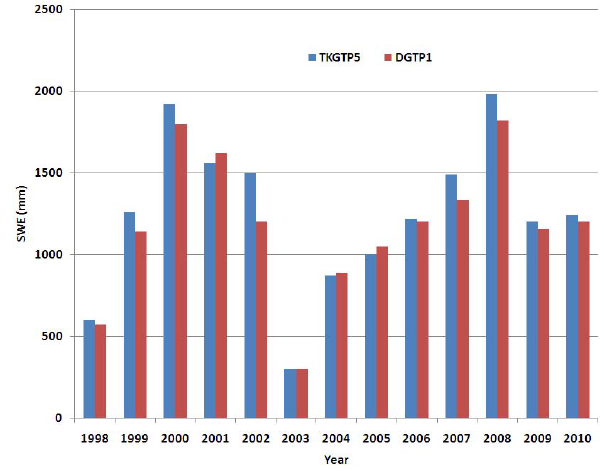
Fig. 3. TKTP5 and DGTP1 testpit SWE 1998–2010 at 1000m on Taku Glacier. Fig. 4. Juneau Icefield annual snow pit measurements near the ELA on Taku Glacier from 1998–2010 in mm of